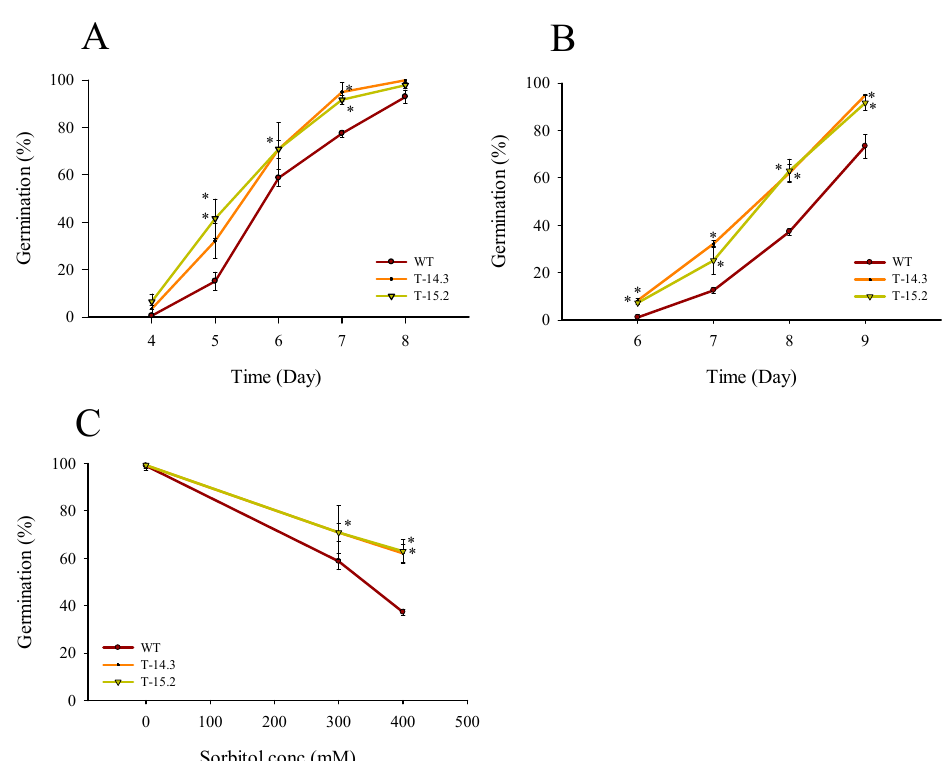
Figure 7. Seed germination rates of WT and AnnA8 overexpressing transgenic tobacco plants under osmotic stress condition. ( A , B ) are day wise percentages of seed germination respectively on 300 and 400 mM sorbitol; ( C ) Sorbitol dose response on the seed germination, percentage value of seed germination on 0, 300 and 400 mM sorbitol were taken on day 4, 7 and 8, respectively, from the date of plating on the media, for each biological replicate (n) 150 seeds of WT and transgenic lines were taken. Data represent means of n = 3 ± SE. An asterisk indicates that the mean values of transgenic lines were significantly higher than that of WT (control) when analyzed by one-way ANOVA ( p < 0.05). For seedling stress assay, 10 day-old seedlings were transferred to the half strength MS medium with different concentrations (100–200–300 mM) of sorbitol. No differences were observed between the WT and the transgenic lines at 100 mM sorbitol concentration. At 200 mM, there were significant differences in the root and shoot growth of transgenic seedlings compared to WT (data not shown).